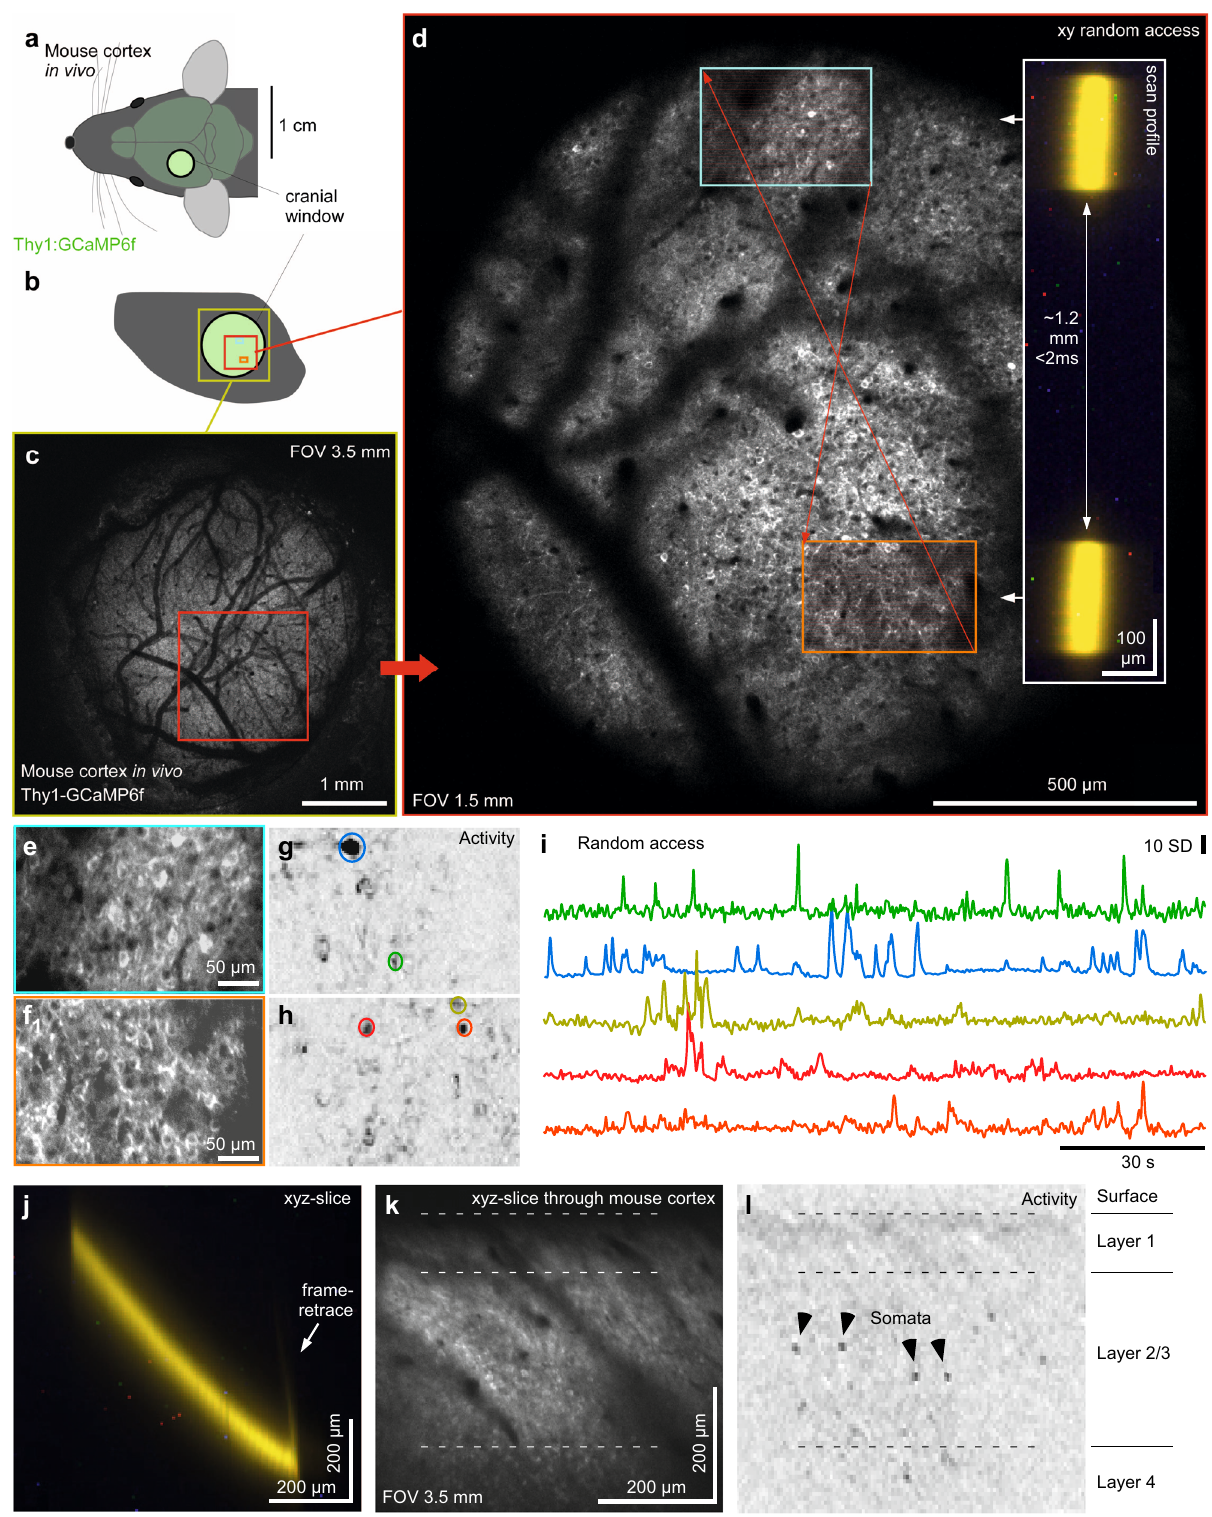
Fig. 9 Mesoscale random-access imaging of mouse cortex in vivo. a , b Schematic of Thy1:GCamP6f mouse brain in vivo ( a ) with cranial window over the somatosensory cortex ( b ). c , d 1024 × 1024 px nTC 2 ( c ) and nTC 1 ( d ) images as indicated. Red arrows indicate rapid transitions between scan regions, with the inset indicating the scan-pro fi le. e – i 2 times 128 × 256 px (3.91 Hz) random access scan as indicated in ( d ) with mean-projection ( e , f ), activity- correlation ( g , h , cf. Fig. 3c) and fl uorescence traces ( i ), taken from the ROIs as indicated in ( g , h ). j – l nTC 1 128 × 128 px xyz-tilted plane (7.82 Hz) traversing through cortical layers 1 – 4 at ~45° relative to vertical (such that the x-image dimension corresponds to the x-mirror, while the y-dimension in the image represents simultaneous and matched y- and z-movement, with mean image ( k ) and activity-correlation ( i , cf. Fig. 3c). The scan was taken under nTC 2 3.5 mm FOV con fi guration and zoomed in to the central ~0.6 mm.